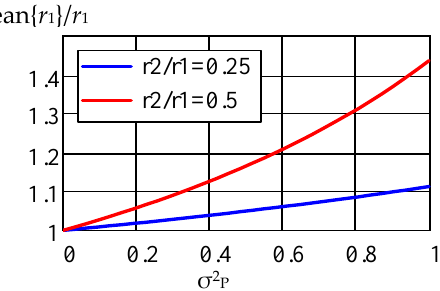
Figure 7. Dependence of the normalized value of the average value of the estimate r 1 on the param- eter σ 2P for two values of the ratio of radii r 2 / r 1.